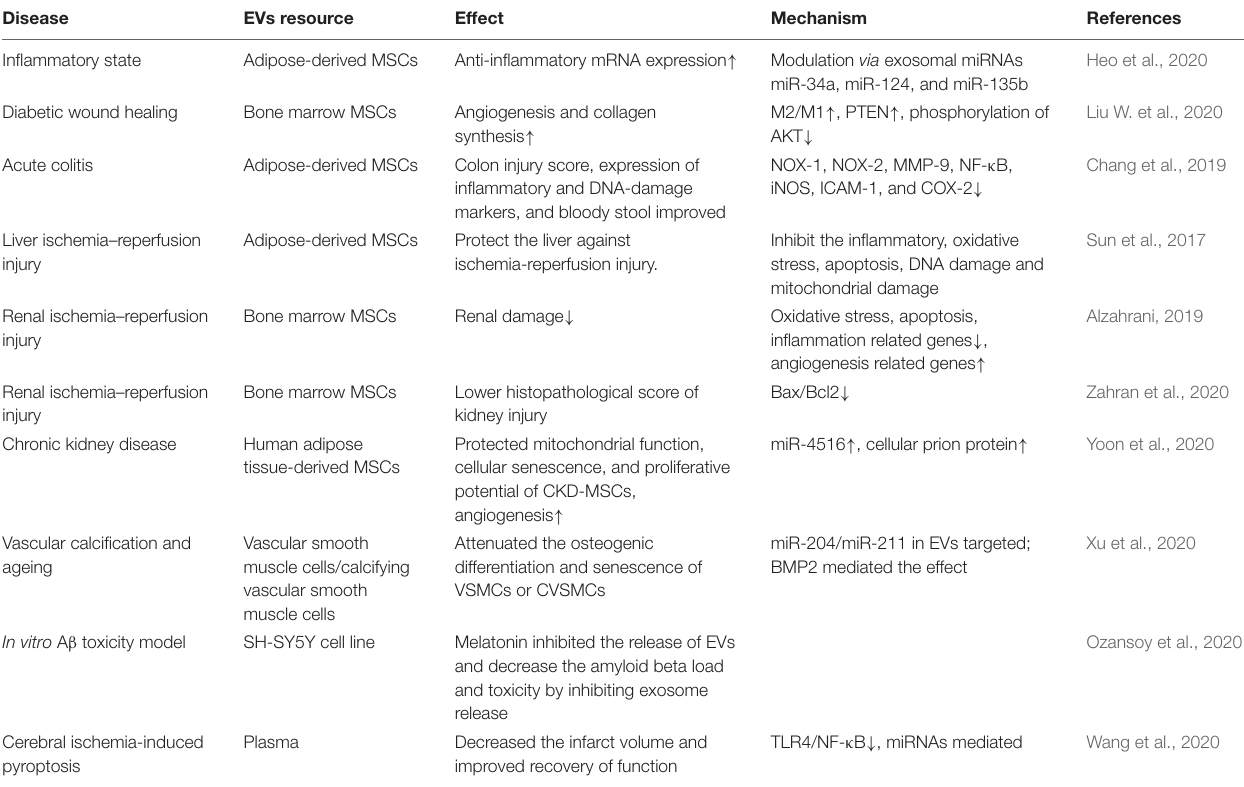
TABLE 2 | Melatonin enhances the activity of extracellular vesicles (EVs) to rescue the function of multiple